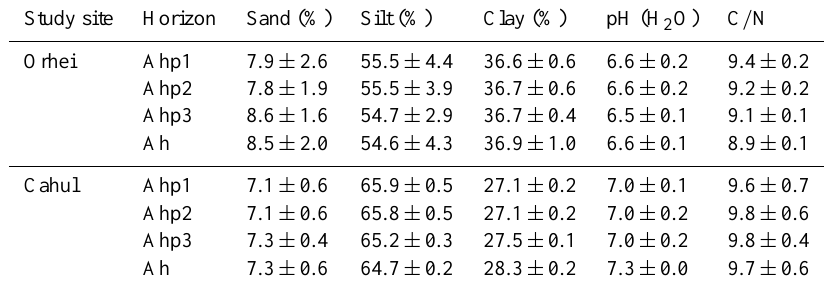
Table 2. Basic soil properties (soil texture, pH, C / N ratio) of topsoil horizons of experimental sites in Orhei and Cahul (mean values ± SD, n = 3).